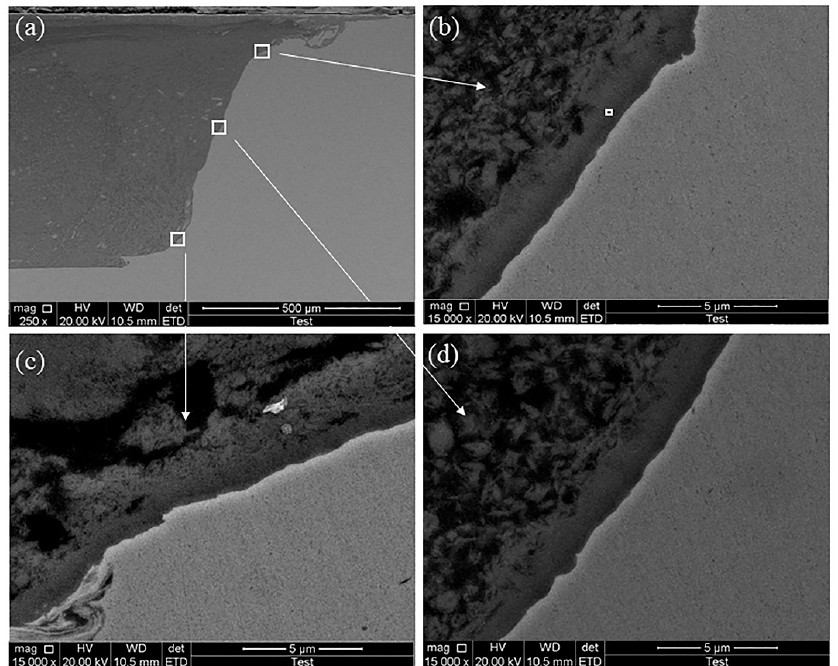
Figure 7. SEM image of HRS-FSW interface and EDS measuring position under a low tool offset. ( a ) Low magnification SEM picture, ( b ) SEM Al-Fe interface picture at the top and EDS point scan position, ( c ) SEM Al-Fe interface picture in the middle, ( d ) SEM Al-Fe interface picture at the bottom.